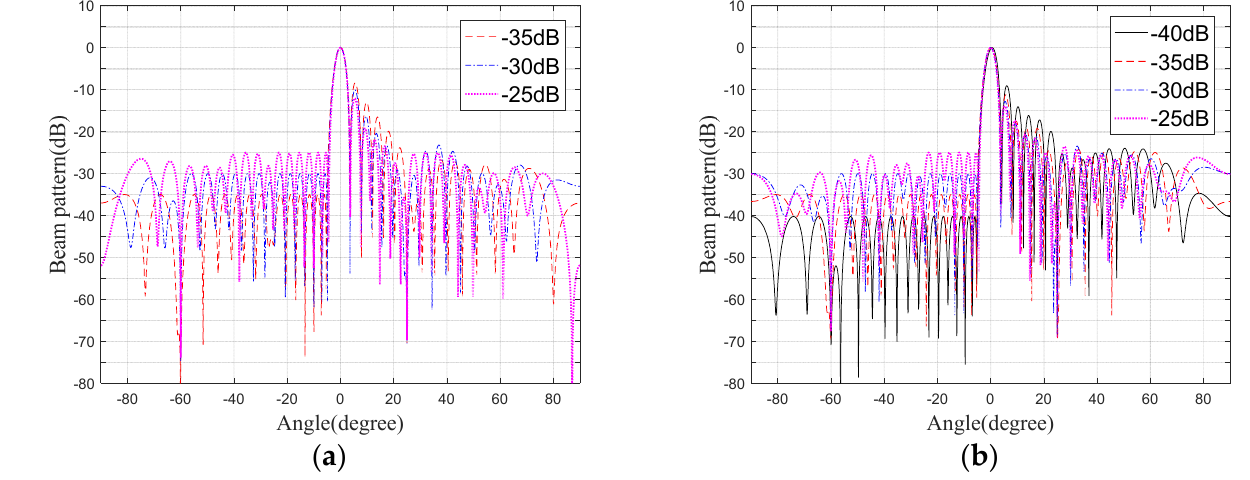
Figure 4. Beampatterns under the same PAPR upper bound and different sidelobe thresholds. ( a ) PAPR upper bounds = 1.2. ( b ) PAPR upper bounds = 1.4.